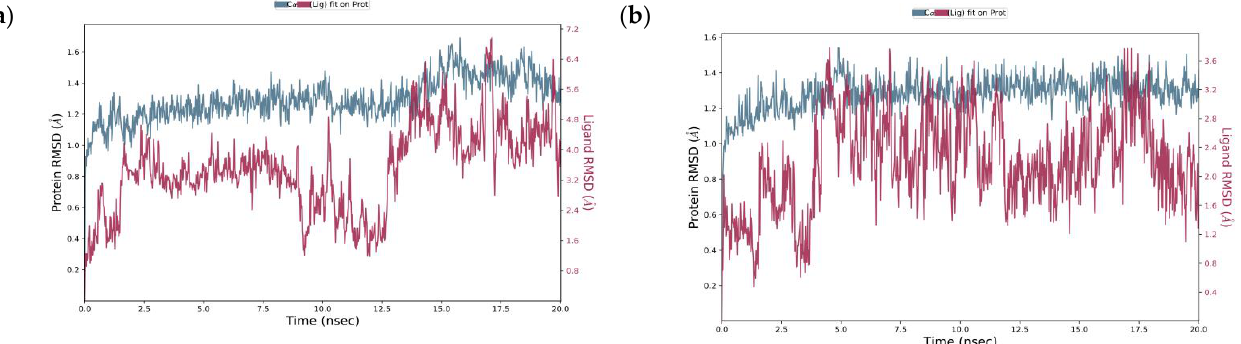
Figure 3. Root mean square deviation (RMSD) of alpha carbon (C α ) of the receptor (blue) and ligand (red) of ( a ) acarbose and ( b ) naringenin, on the α -glucosidase binding site during the 20 ns simulation.